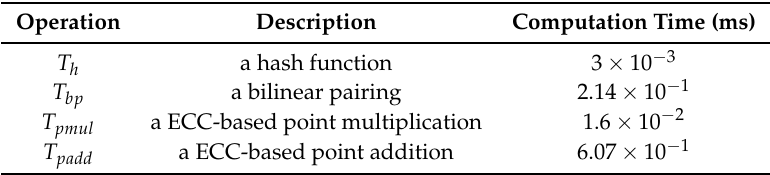
Table 2. Approximate running time of